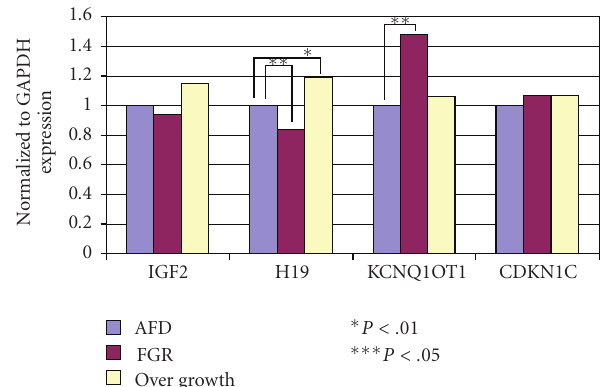
Figure 3: Gene expression in placental tissue. FGR and birth weight ≥ 3500 g cases in the SC group. H19 expression was significantly reduced in FGR cases, but significantly enhanced in cases with a birth weight of ≥ 3500 g ( P <